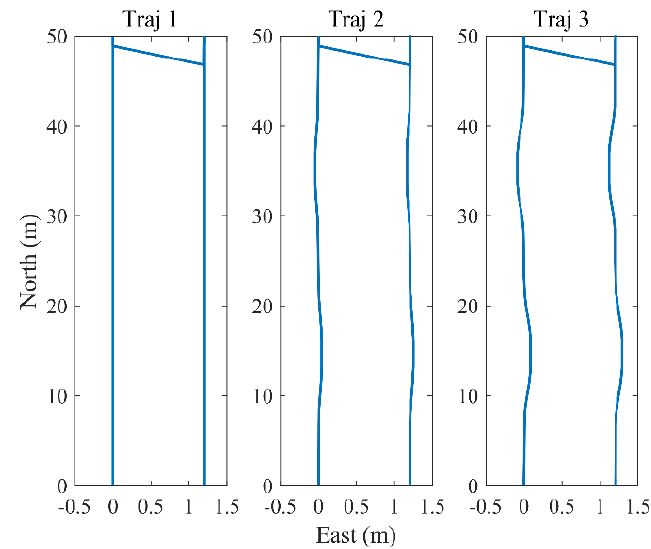
Figure 9. The simulation trajectories of different curvatures.